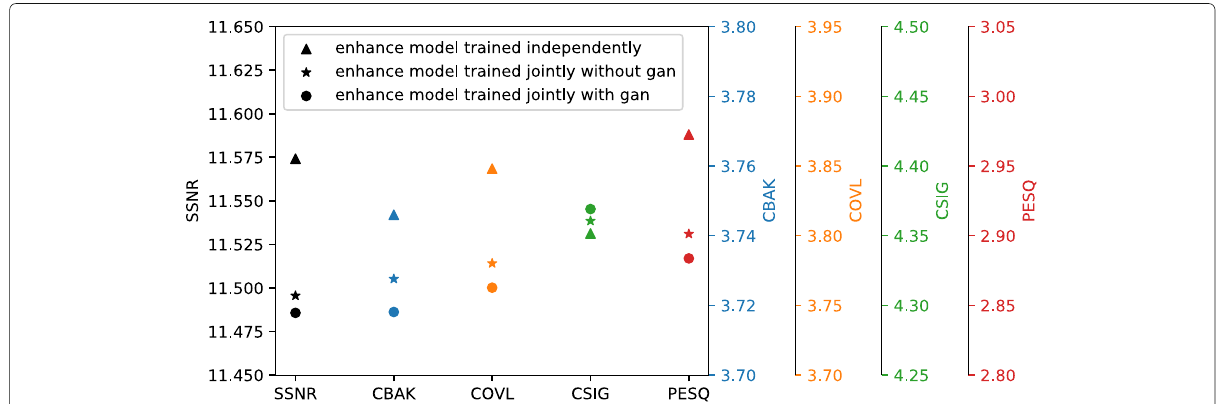
Fig. 8 The performance comparison of the enhancement model trained independently and the enhancement models trained jointly with Conformer ASR model without and with